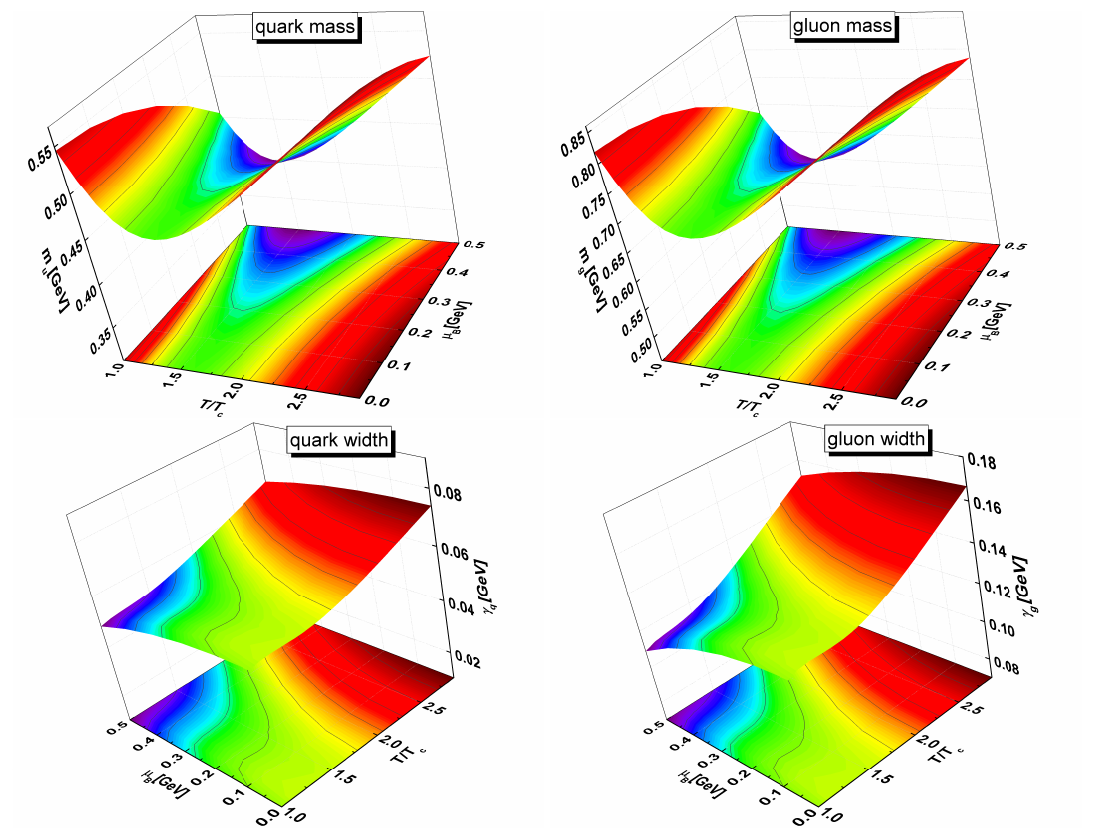
Figure 1. The effective quark ( left ) and gluon ( right ) masses M ( upper row ) and widths γ ( lower row ) as a function of the temperature T and baryon chemical potential µ B